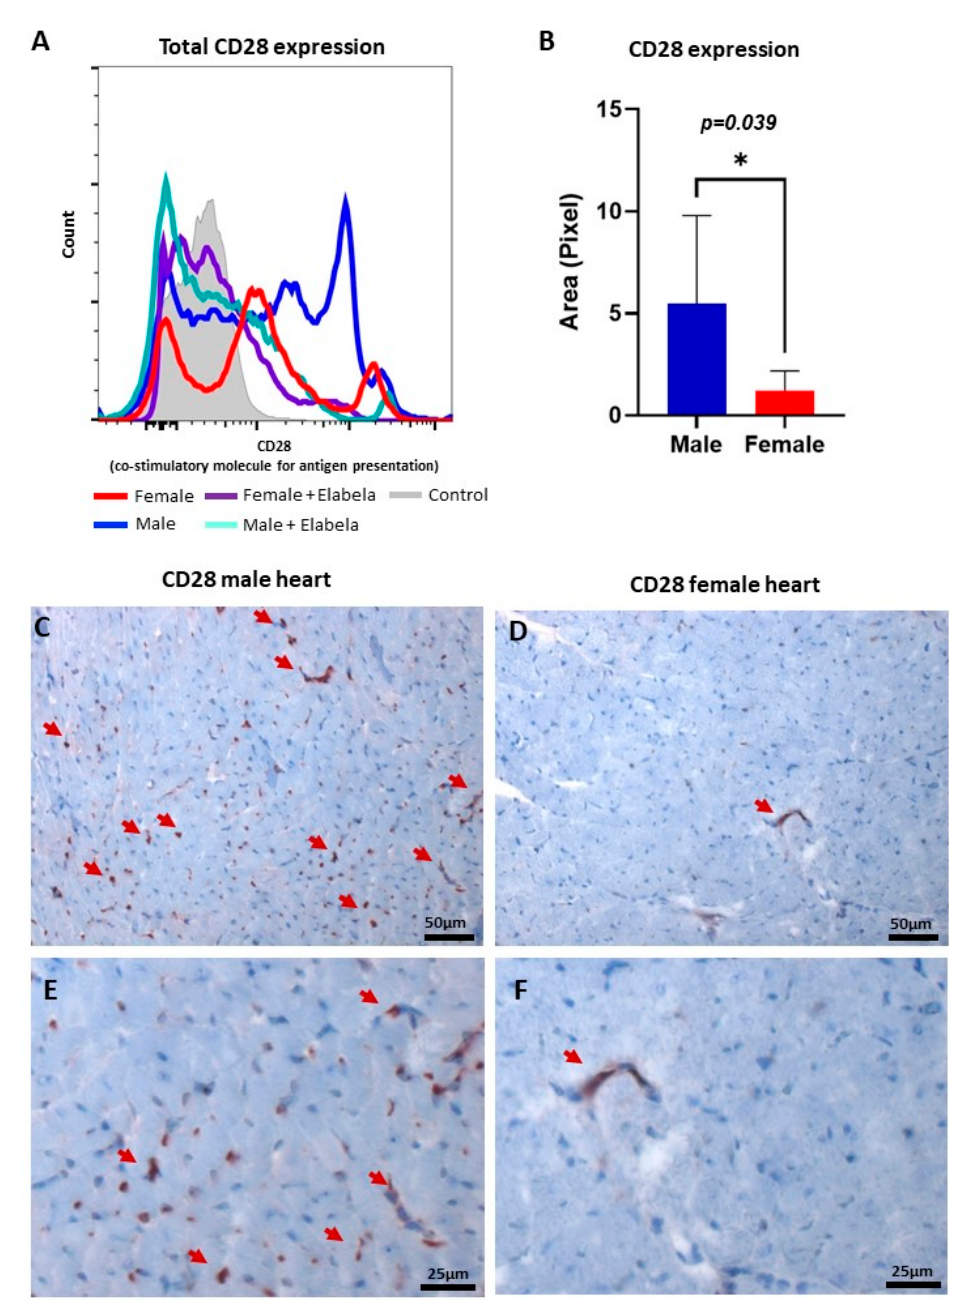
Figure 3. Regulation of CD28 co-stimulatory protein by Elabela in a sex-dependent fashion. ( A ) His- togram panel of flow cytometry analysis demonstrated that Elabela could reduce the expression of CD28 in T cells, modulating their activation. ( B ) Area in pixel for CD28 expression in male versus female normal heart tissues, quantifying the expression level in cardiac tissues of both sexes using Immunohistochemistry. Microscopic images showing the presence of CD28 (brown color) in male ( C ) and female ( D ) hearts, magnification 200×. ( E , F ) Shown in higher magnification (400×), the ex- pression of CD28 in male and female hearts, respectively. The arrows point to cells positive for CD28. * p ≤ 0.05 .